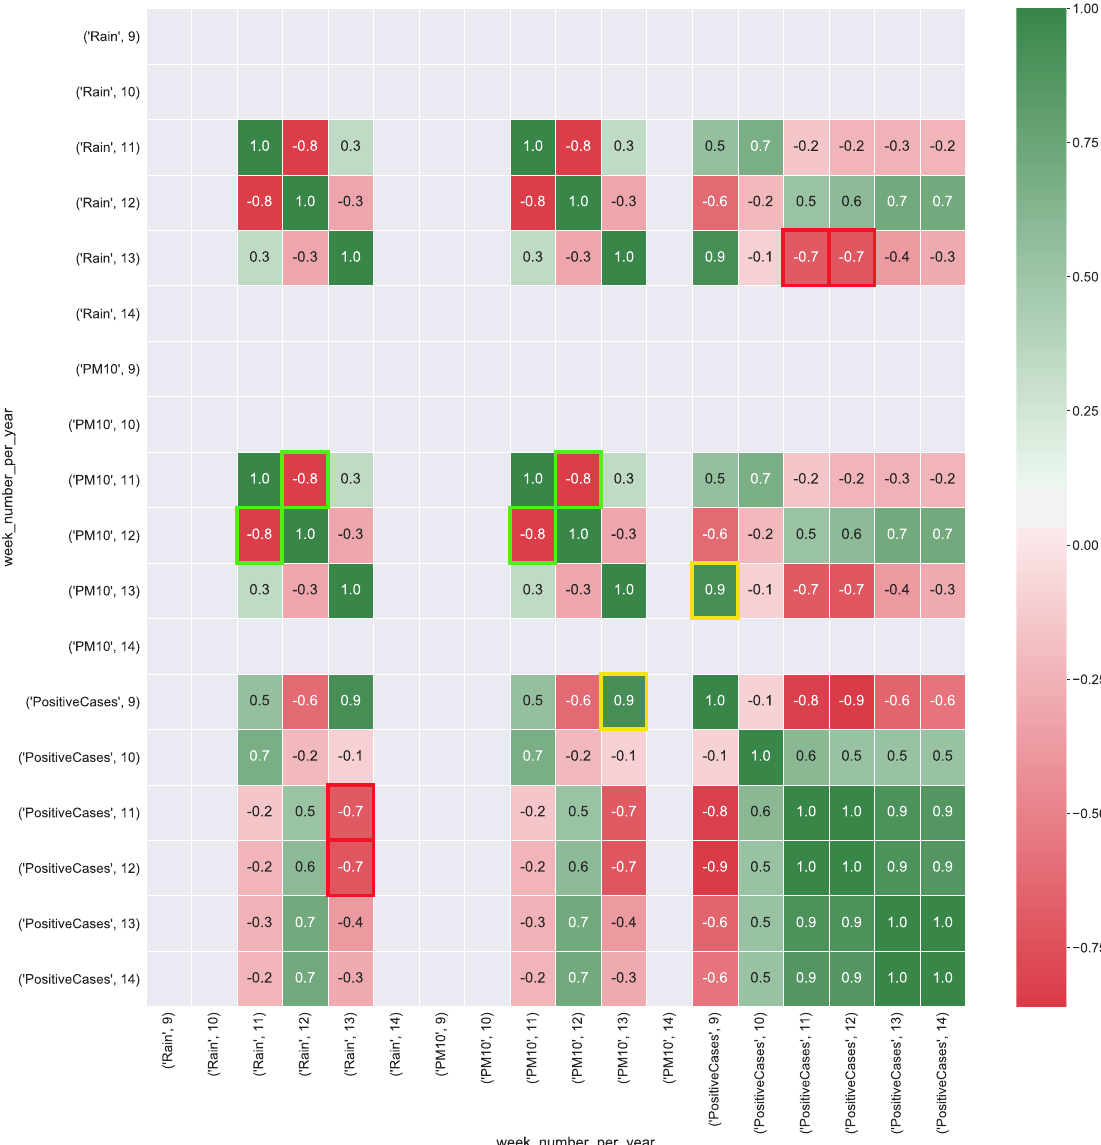
Figure 7. Heatmap representation of correlation between COVID-19 data aggregate with the air pollution and rain data (boolean variable) detected in the Puglia region. The heatmap’s labels refer to the attribute’s measured value in a specific week of the year. For instance, ’PM10’, 9 refers to the level of PM10 ( µ g/m 3 ) in the air measured in the 9-th week of the year. In Figure, the yellow squares highlight the strong positive correlation between positive cases and the presence of air particulate PM10, whereas red squares show the strong negative correlation between rain and the number of positive cases. Green squares show strong negative correlation between rain and PM10